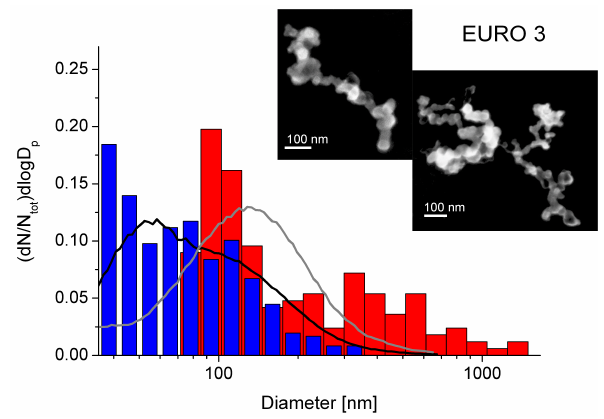
Fig. 2. Size distribution of the particles emitted from the EURO 2 transporter, the red and blue bars represent size distributions from fresh and aged soot particles, respectively. The black and grey lines represent the SMPS size distribution from fresh and aged particles, respectively. The diameters of the particles in the SEM images are: 250nm for the fresh particle (left) and 300nm for the aged particle (right).